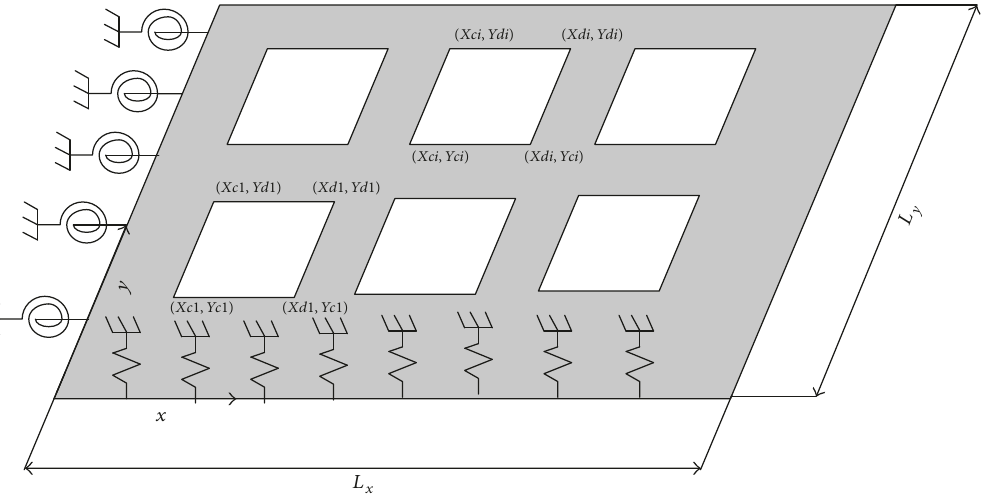
Figure 1: The flexible plate with